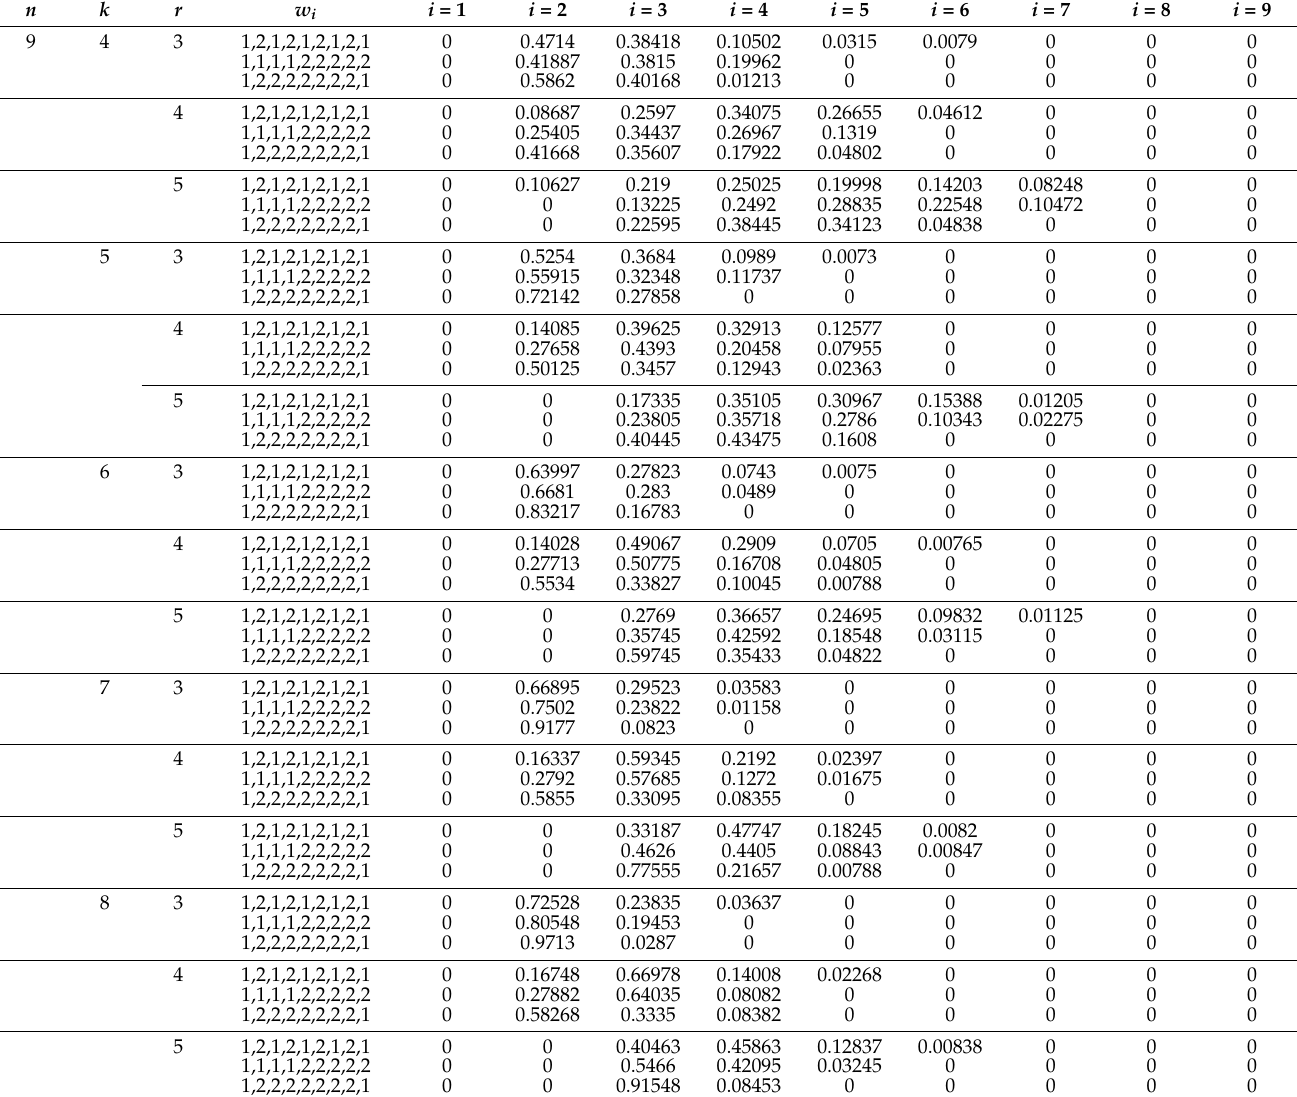
Table 5. The signature of the weighted- r -within-consecutive- k -out-of-9: F